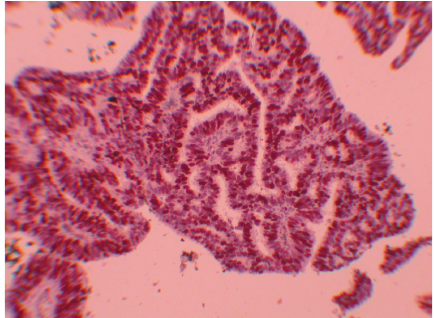
Figure 1: Appearance of the papillae in villoglandular papillary adenocarcinoma of the uterine cervix (H&E stain, × 40).